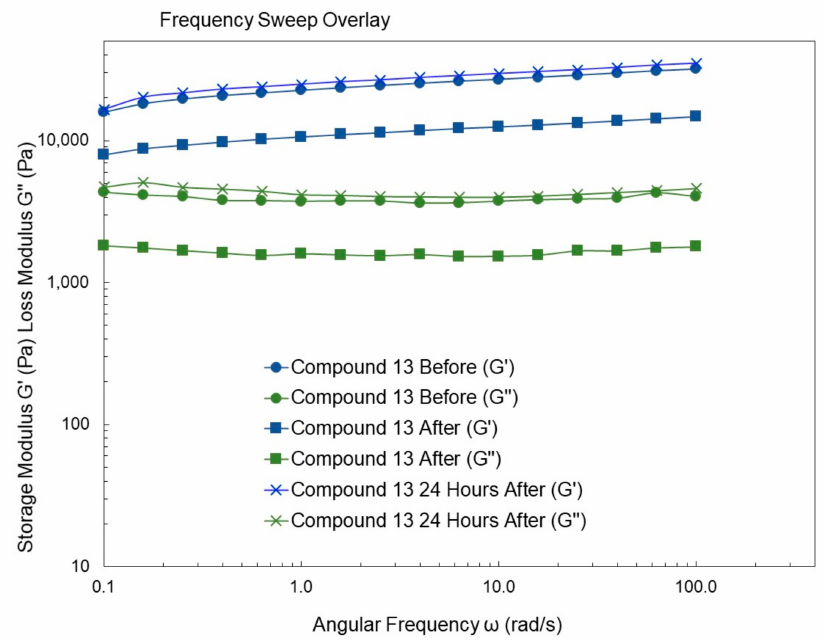
Figure 11. Rheology properties (frequency sweep, 0.5% strain) of a gel of compound 13 in DMSO/H 2 O 1:1 at 5 mg/mL before and after extrusion, and 24 h after extrusion.